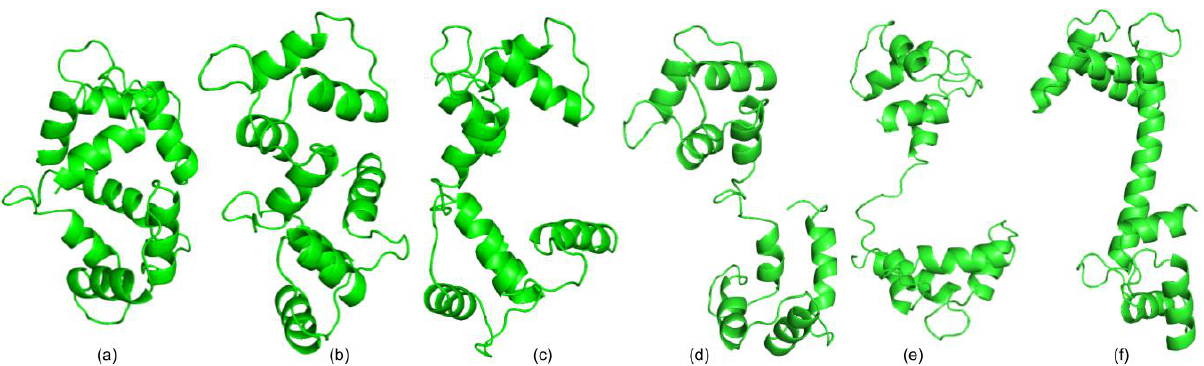
Figure 4. The simulated conformational path for CaM, from 1 CTR ( a ) to 1 CLL ( f ). Conformations ( b – e ) are the intermediate conformations for this path, taken at approximately equal